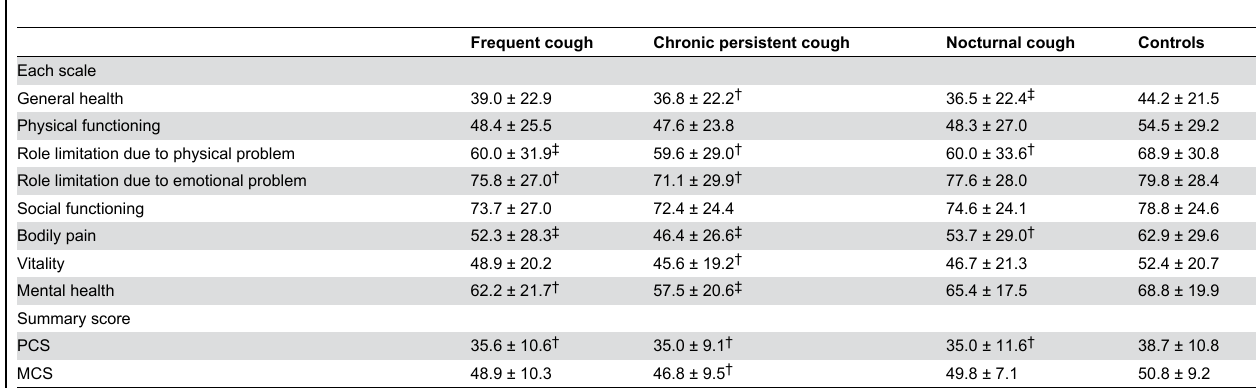
Table 5. SF-36 HRQoL questionnaire scores according to the presence of